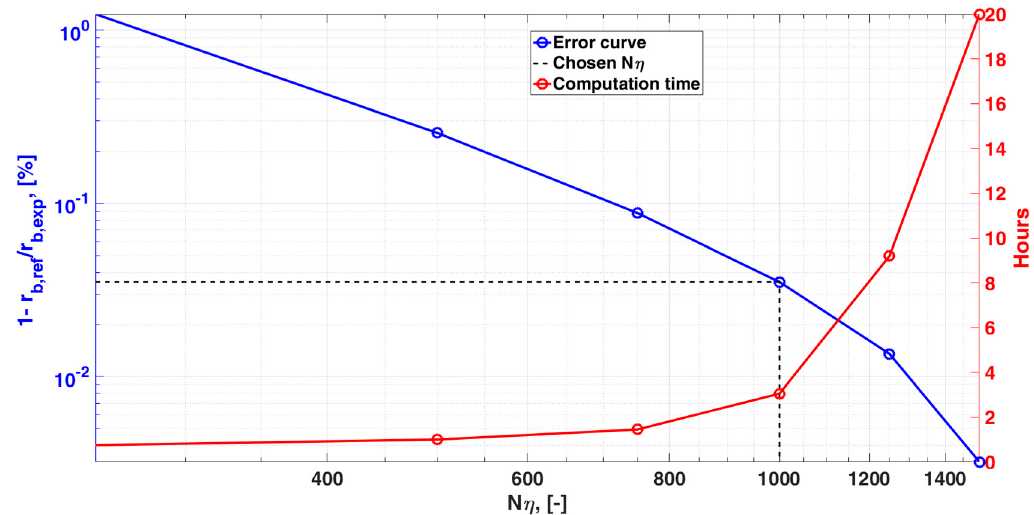
Figure 18. Grid dependence analysis and computation time.